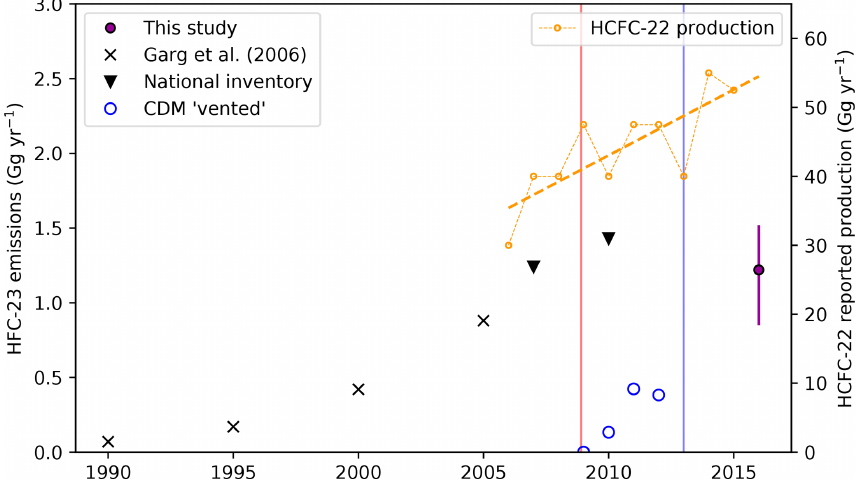
Figure 7. HFC-23 emissions (Ggyr − 1 ) from bottom-up and top-down estimates. Bottom-up estimates are from Garg et al. (2006) (black crosses), from India’s Second National Communication (Ministry of Environment, Forest and Climate Change, 2012), and from the Biennial Update Report (Ministry of Environment, Forest and Climate Change, 2015) to the UNFCCC for 2007 and 2010 (left and right black triangles, respectively). The top-down estimate derived here is plotted as a purple circle with corresponding 5th–95th percentile uncertainties. Blue circles show the total amount of “vented” (i.e. released to the atmosphere) HFC-23 per year, as reported by the five HCFC-22 manufacturers during the CDM period. Reported HCFC-22 production (Ggyr − 1 ) data is shown in orange circles and extrapolated to 2016 using a linear fit (dashed orange line). The red bar indicates the first year (2009) in which all five manufacturers of HCFC-22 reported the use of an abatement system and the blue bar indicates the point (January 2013) at which the European Union banned the use of HFC-23 credits under the EU Emissions Trading Scheme. Note the split y axes – HFC-23 emissions estimates are plotted with respect to the left-hand axis, while HCFC-22 production data is plotted with respect to the right-hand